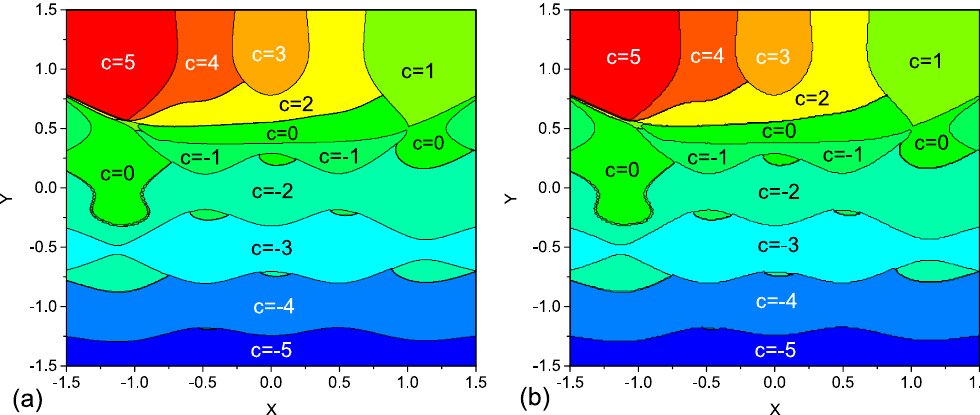
Figure 3. Phase diagrams for system with parameters satisfying the equation (40) identified by Chern numbers. The Chern number is obtained by two ways: ( a ) It is computed by the winding numbers from formula in Eq. (27). ( b ) It is computed by the number of zero modes with the sign of Majorana charge defined in Eq. (55). The result is obtained by exact diagonalization for Hamiltonian in Eq. (51) on N = 200 chain. The units of x and y are the same as that of J n , which is taken as dimensionless